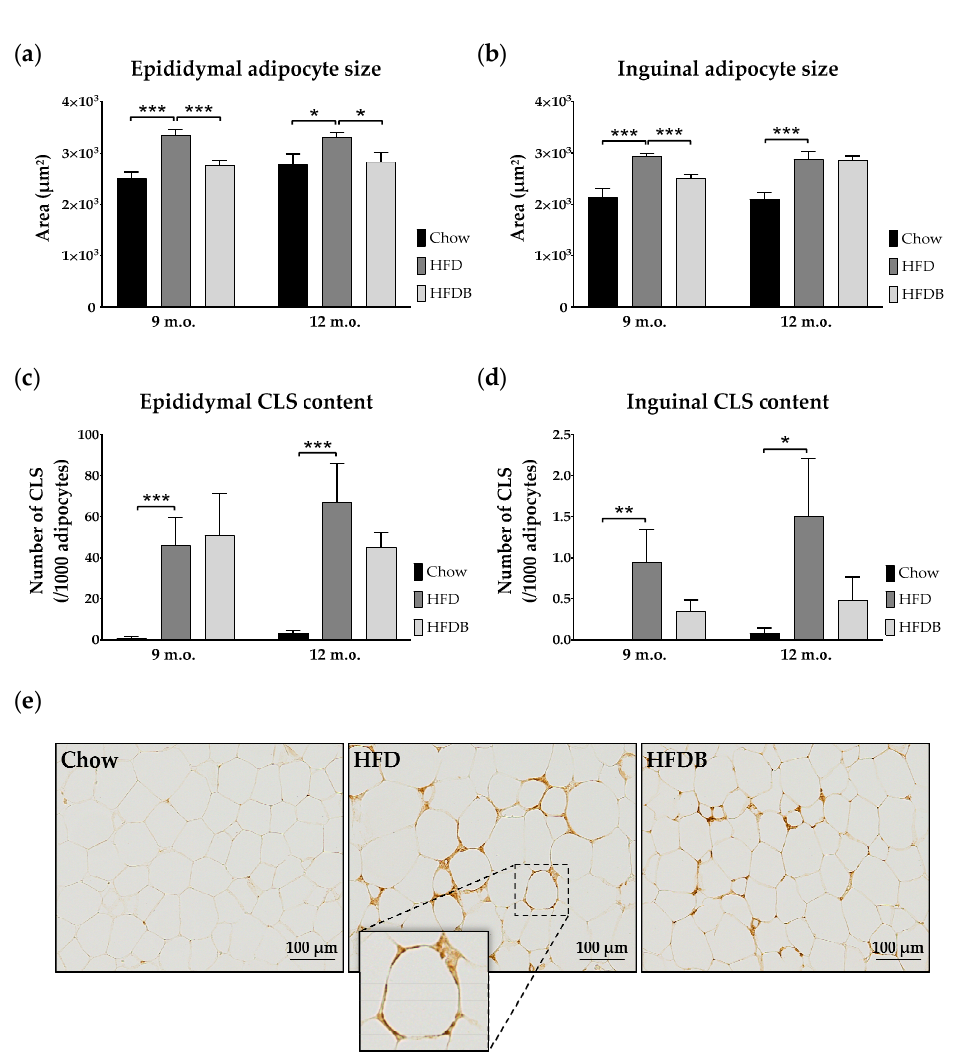
Figure 2. Adipose tissue cell sizes and macrophage infiltration. Mean adipocyte sizes in epididymal ( a ) and inguinal ( b ) adipose tissue depots in both mid- (9 m.o.) and late- (12 m.o.) adult mice. ( c , d ) Mean number of crown-like structures (CLS) in epididymal ( c ) and inguinal ( d ) adipose tissue. ( e ) Representative photomicrographs of epididymal adipose tissue stained with antibodies against macrophages (MAC-3) in late-adult mice. In addition, a magnification (40 × ) of a CLS is represented. These examples are comparable to those observed in mid-adulthood. Data are presented as mean ± standard error of mean (SEM). * p < 0.05; ** p < 0.01; *** p ≤ 0.001.